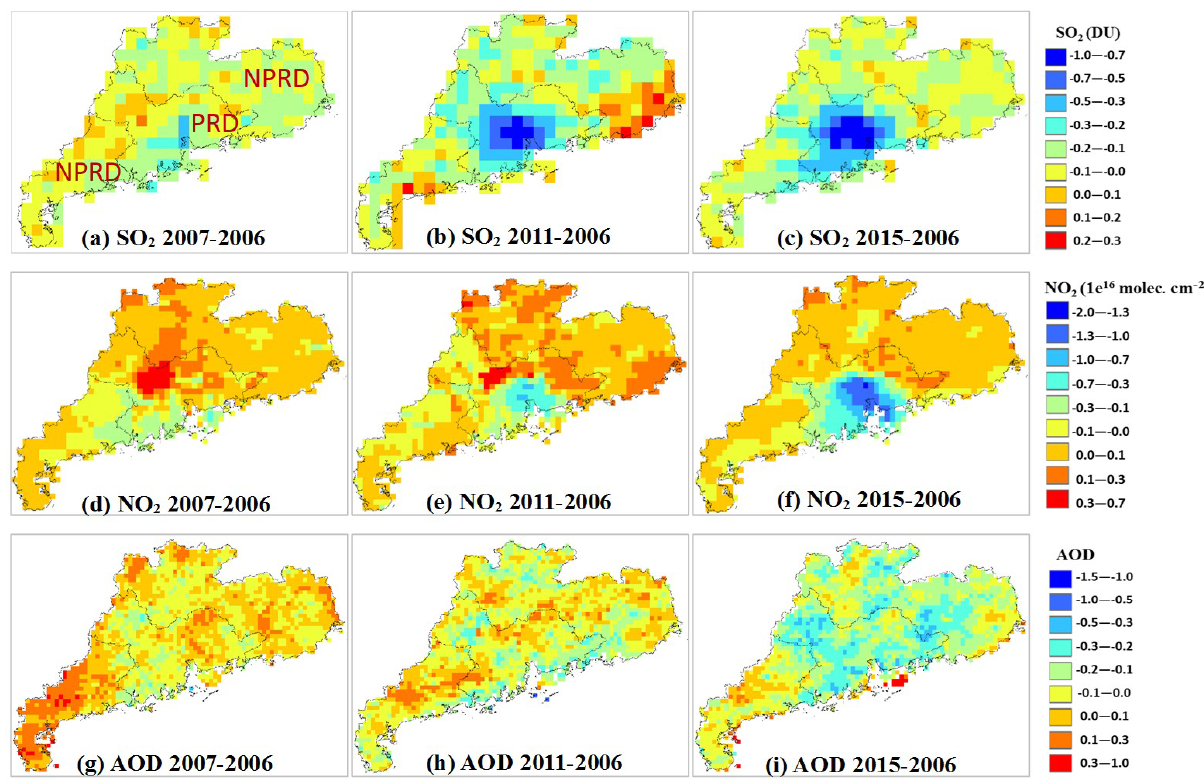
Figure 4. Spatial distributions of satellite observation changes over GD during 2007–2006, 2011–2006, and 2015–2006 for (a) – (c) SO 2 , (d) – (f) NO 2 , and (g) – (i) AOD. The blue color in the legends represents a decline in SO 2 concentrations/NO 2 concentrations/AOD, and the red color denotes an increase. The central zone inside the inner black line presents the PRD region, and outside presents the NPRD